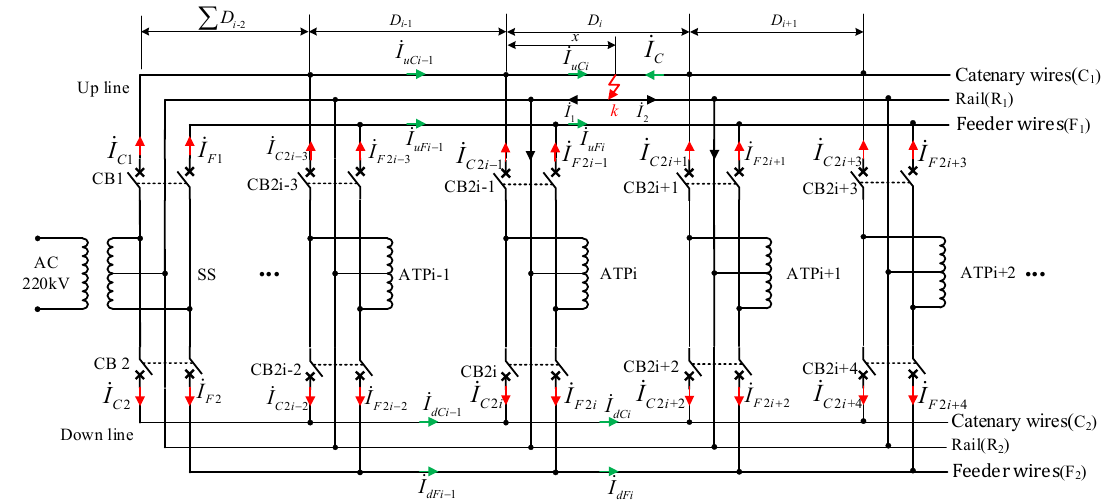
Figure 1. Schematic diagram of an all-parallel autotransformer railway system (AARS). In Figure 1, SS denotes the substation and ATP i ( i = 2… n ) denotes AT post.